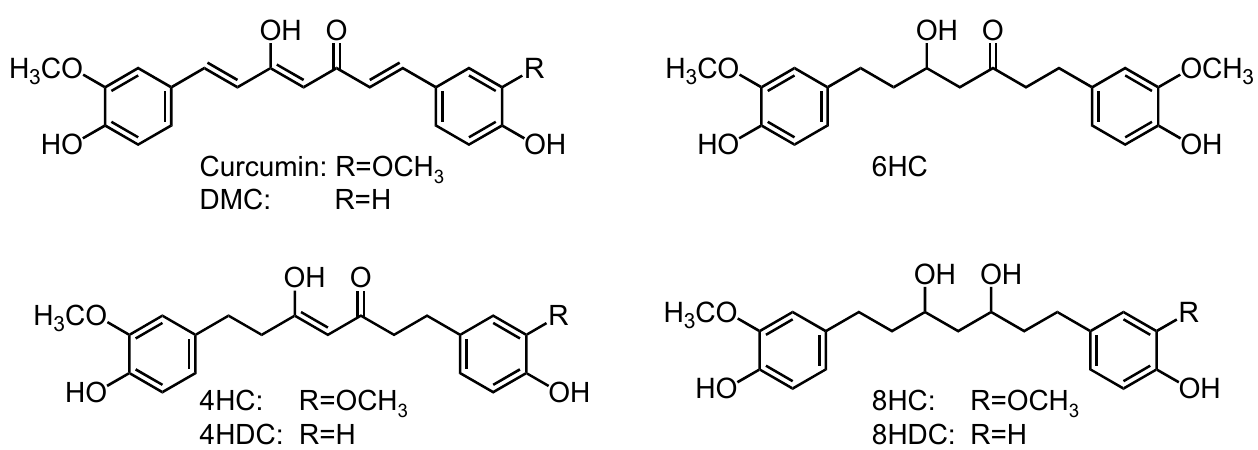
Figure 1. Structures of the curcuminoids and their reduced derivatives studied in this work. DMC: demethoxycurcumin, 4HC: tetrahydrocurcumin, 4HDC: tetrahydro-demethoxycurcumin, 6HC: hexahydrocurcumin, 8HC: octahydrocurcumin, 8HDC: octahydro-demethoxycurcumin.